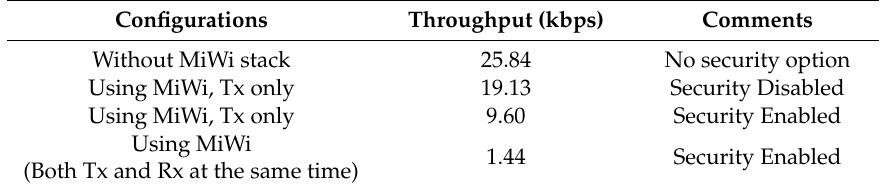
Table 2. Radio throughput under di ff erent network protocol stacks